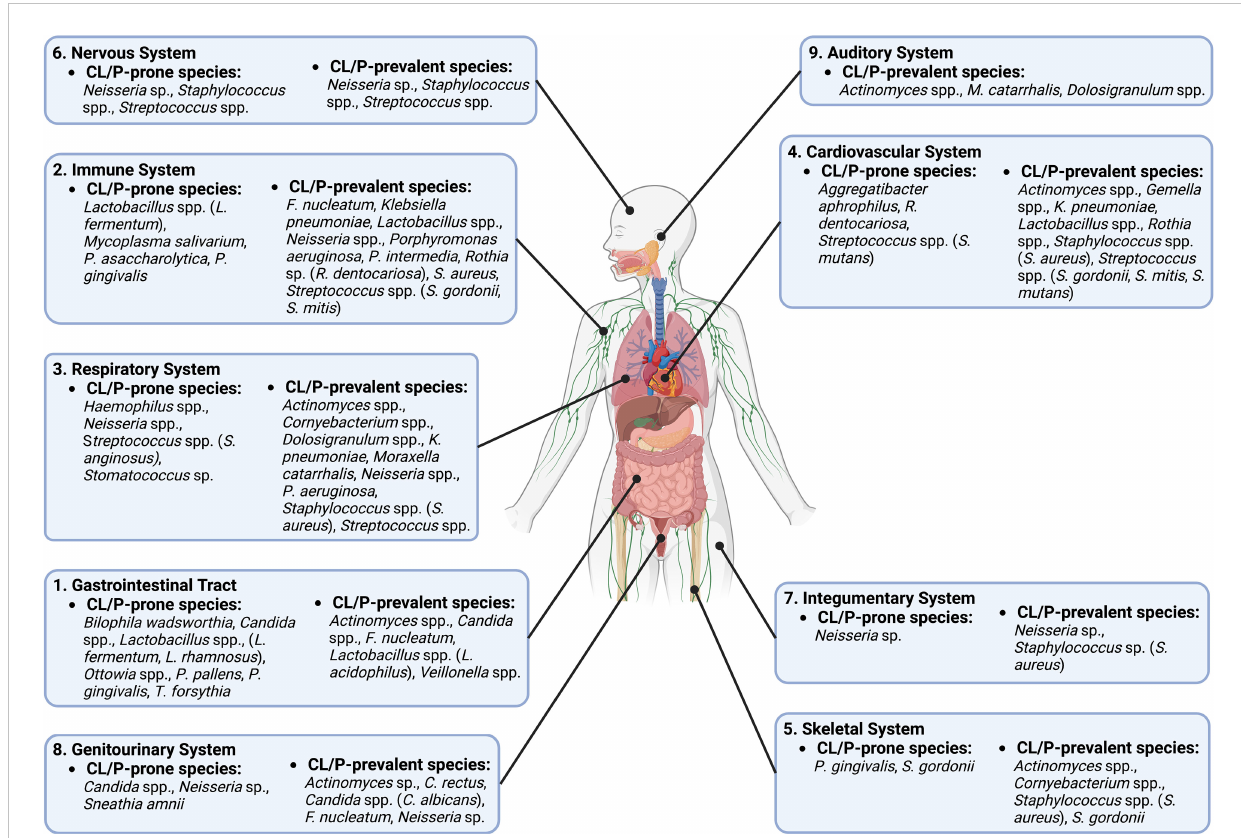
FIGURE 2 A diagram of different body systems that are potentially in fl uenced by CL/P-prone and CL/P-prevalent